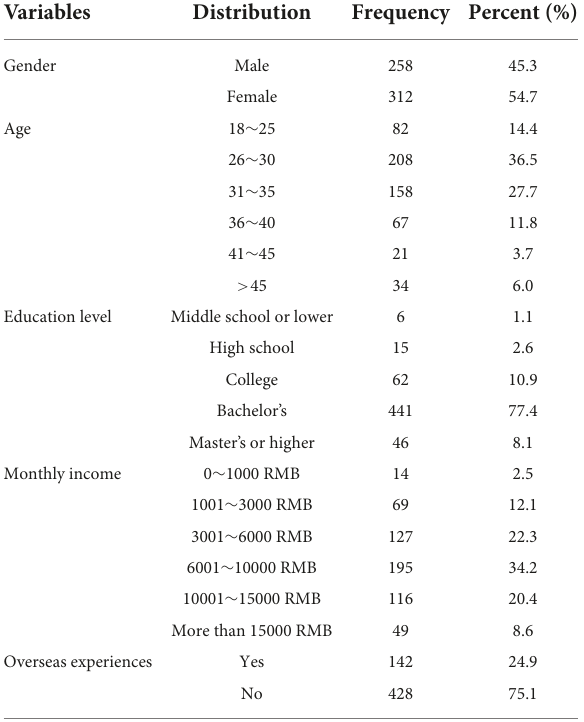
Identification with all